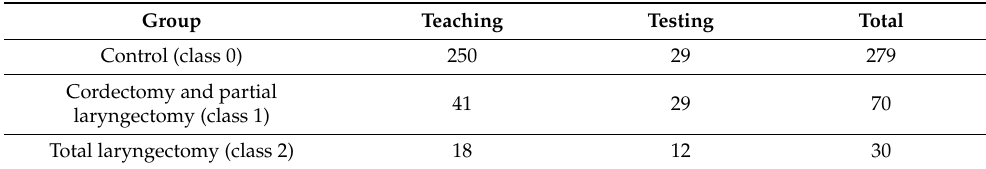
Table 1. Arrangement of the groups in the study.